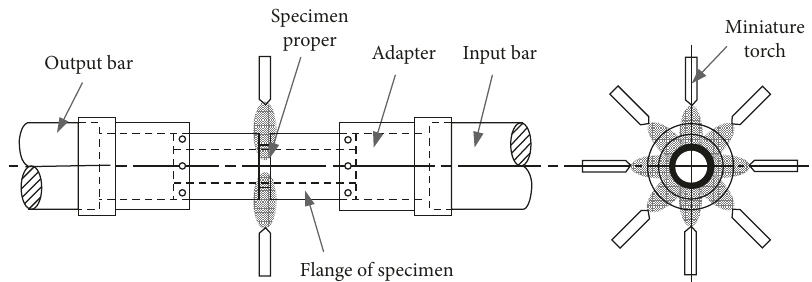
Figure 22: High-temperature technique for TSHB proposed by Gilat and Wu